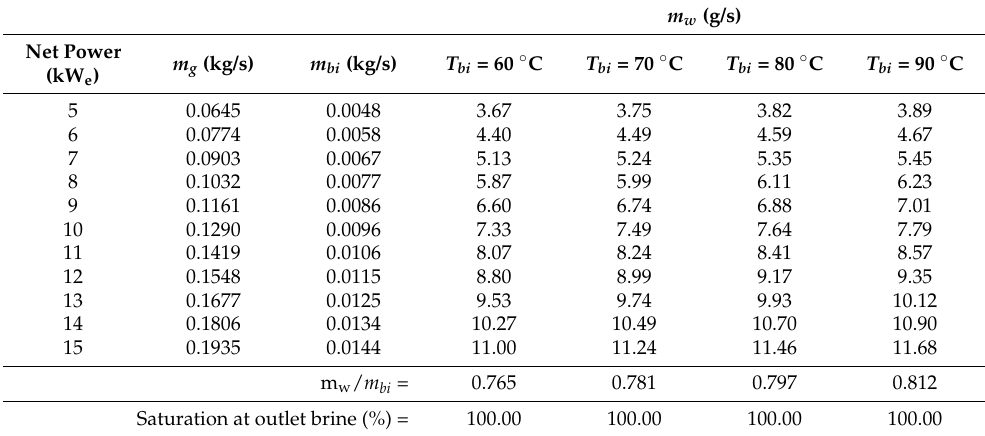
Table 9. Water evaporated for SMGT; Pressure Ratio = 3.5, T gi = 256.61 ◦ C, S bi = 0.07 kg/kg, S sat = 0.296 kg/kg, m g / m bi = 13.45.